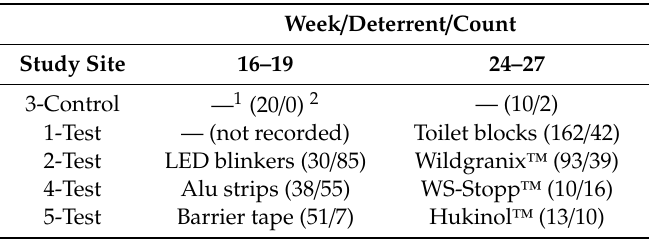
Table 2. Wild boar count at the study sites during test phases.